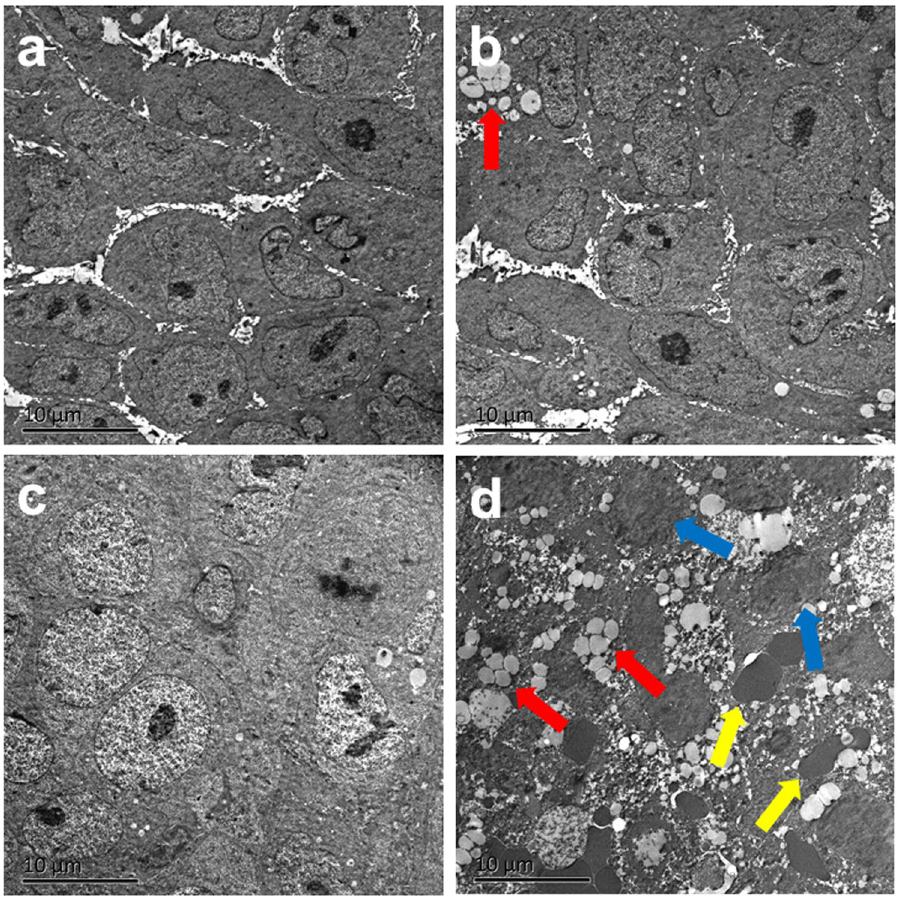
Figure 7. TEM images of tumor tissues from different treatment groups. ( a ) Saline; ( b ) Fe 3 O 4 /ICG@PLGA/PFP NPs only; ( c ) laser irradiation only; and ( d ) Fe 3 O 4 /ICG@PLGA/PFP NPs with laser irradiation. Magnification: 1450 × ; scale bar, 10 μ m. Many generated microbubbles (red arrows) appeared in the tumor tissues. Blue arrows indicate interrupted cells, and yellow arrows indicate red blood